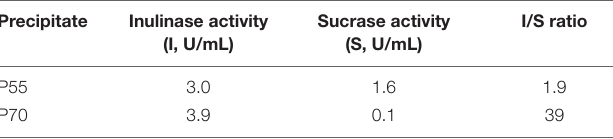
TABLE 2 | The different enzyme activities of precipitates from the inulin-ethanol precipitation of natural inulinase from Aspergillus niger . Precipitate Inulinase activity (I, U/mL)